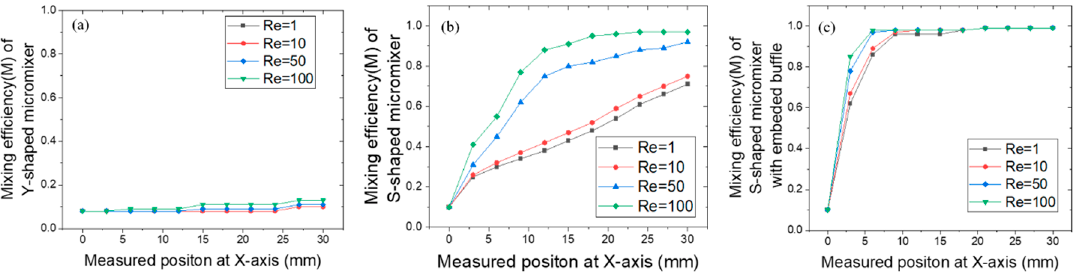
Figure 3. Quantitative mixing efficiency of the three micromixers along the x-axis at different Res: ( a ) Y-shaped, ( b ) S-shaped, and ( c ) S-shaped with embedded baffle.